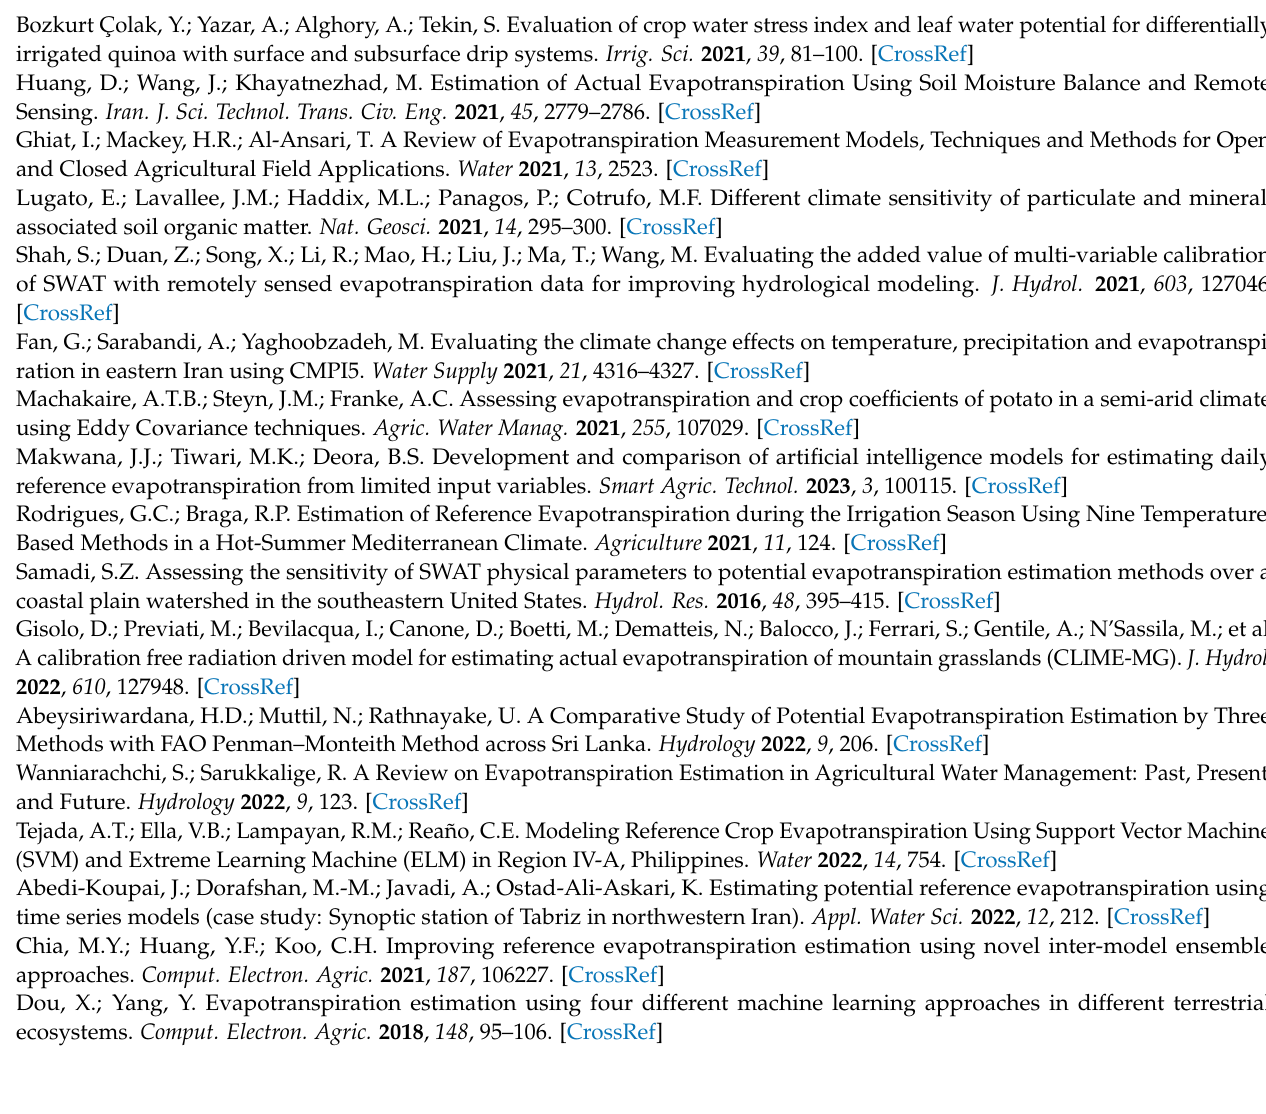
of the observed and predicted ET different SVR based models in the test period of Rajshahi Station. Figure S3. Scatterplots of the observed and predicted ET different SVR based models in the test period of Rangpur